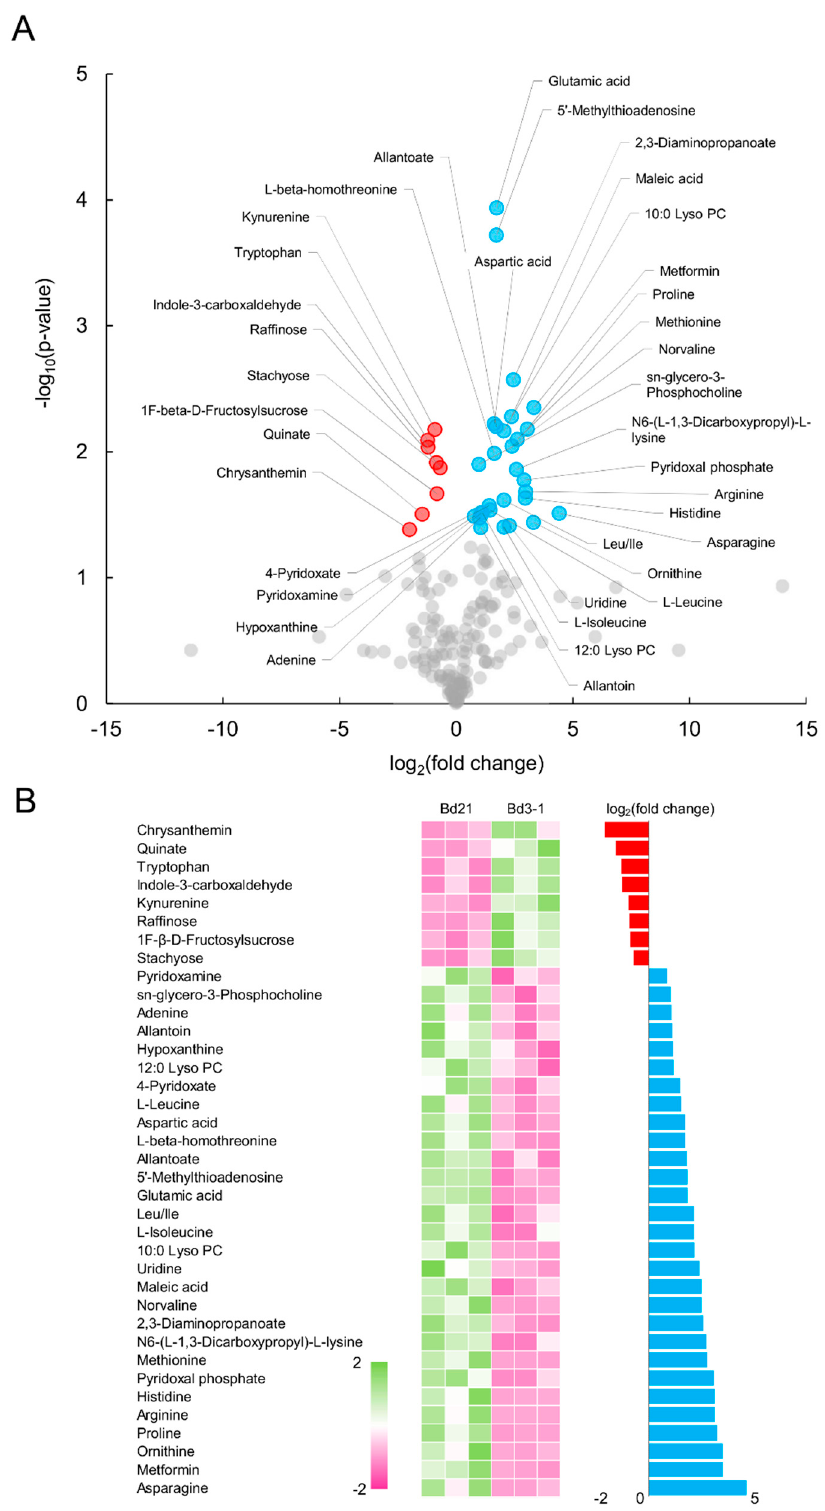
Figure 2. Differentially accumulating metabolites in Bd21 and Bd3-1 seeds. ( A ) Volcano plot representing metabolites in seeds between Bd21 and Bd3-1 ( p < 0.05). ( B ) Accumulation patterns of thirty-seven differentially accumulating metabolites in Bd21 and Bd3-1 seeds as well as their fold change.